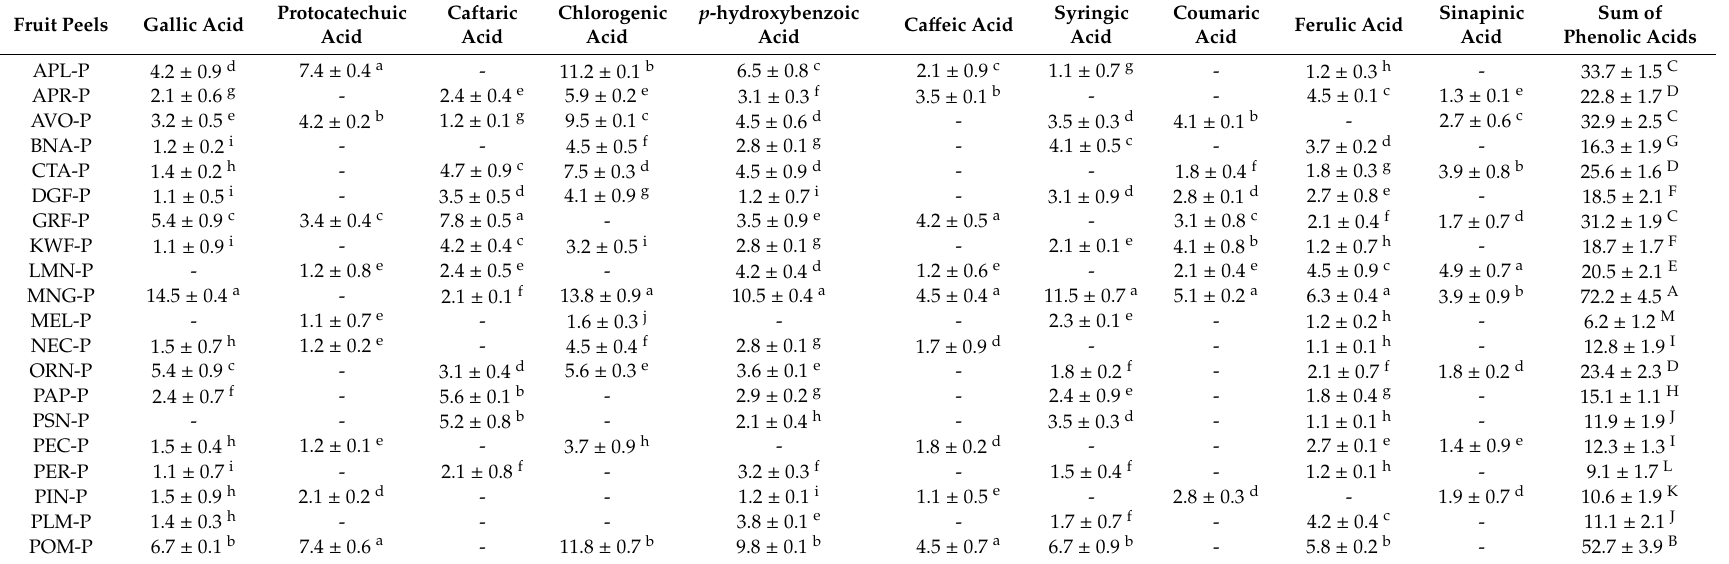
Table 2. Phenolic acids quantified in di ff erent fruit peel samples using